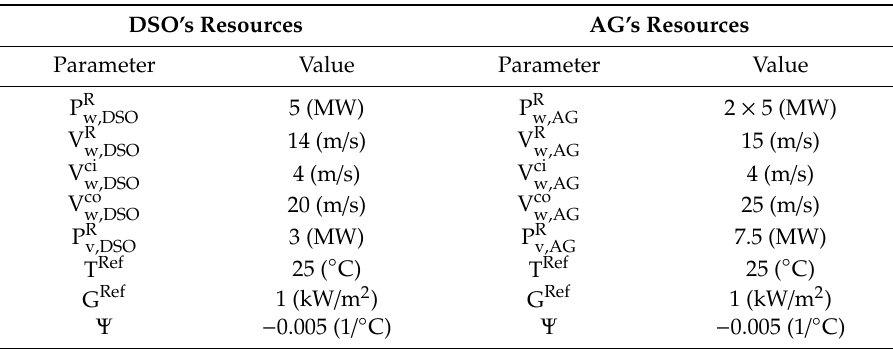
Table 5. Input data of non-dispatchable units.